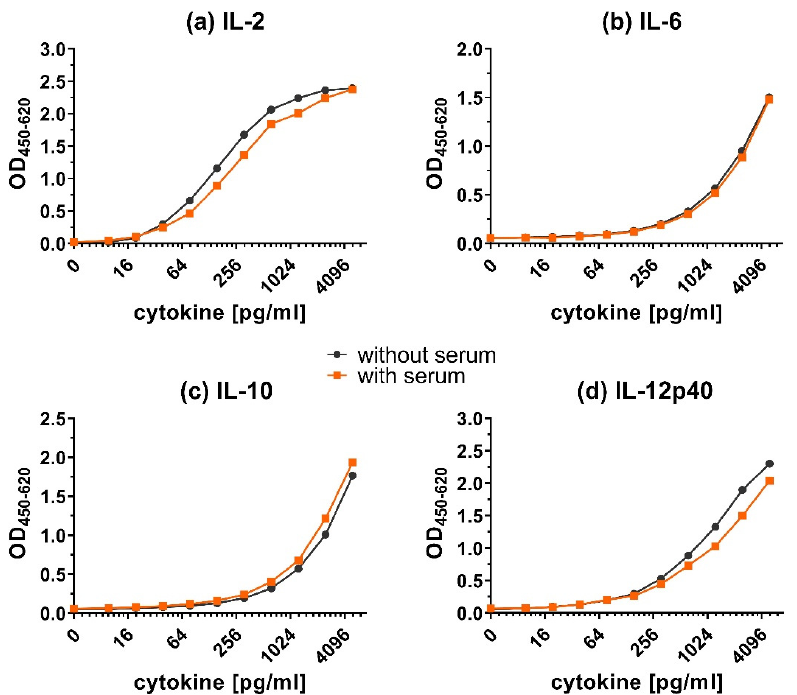
Figure 6. Matrix effect on the detection of cytokines in presence of serum. Calibration curves for ( a ) IL-2, ( b ) IL-6, ( c ) IL-10 and ( d ) IL-12p40 in dilution buffer with or without serum. The capture ELISA was performed with a range of 9.8–5000 pg/mL of recombinant cytokines in dilution buffer (1.5% BSA in PBS) only (without serum) or containing additional chicken plasma (with